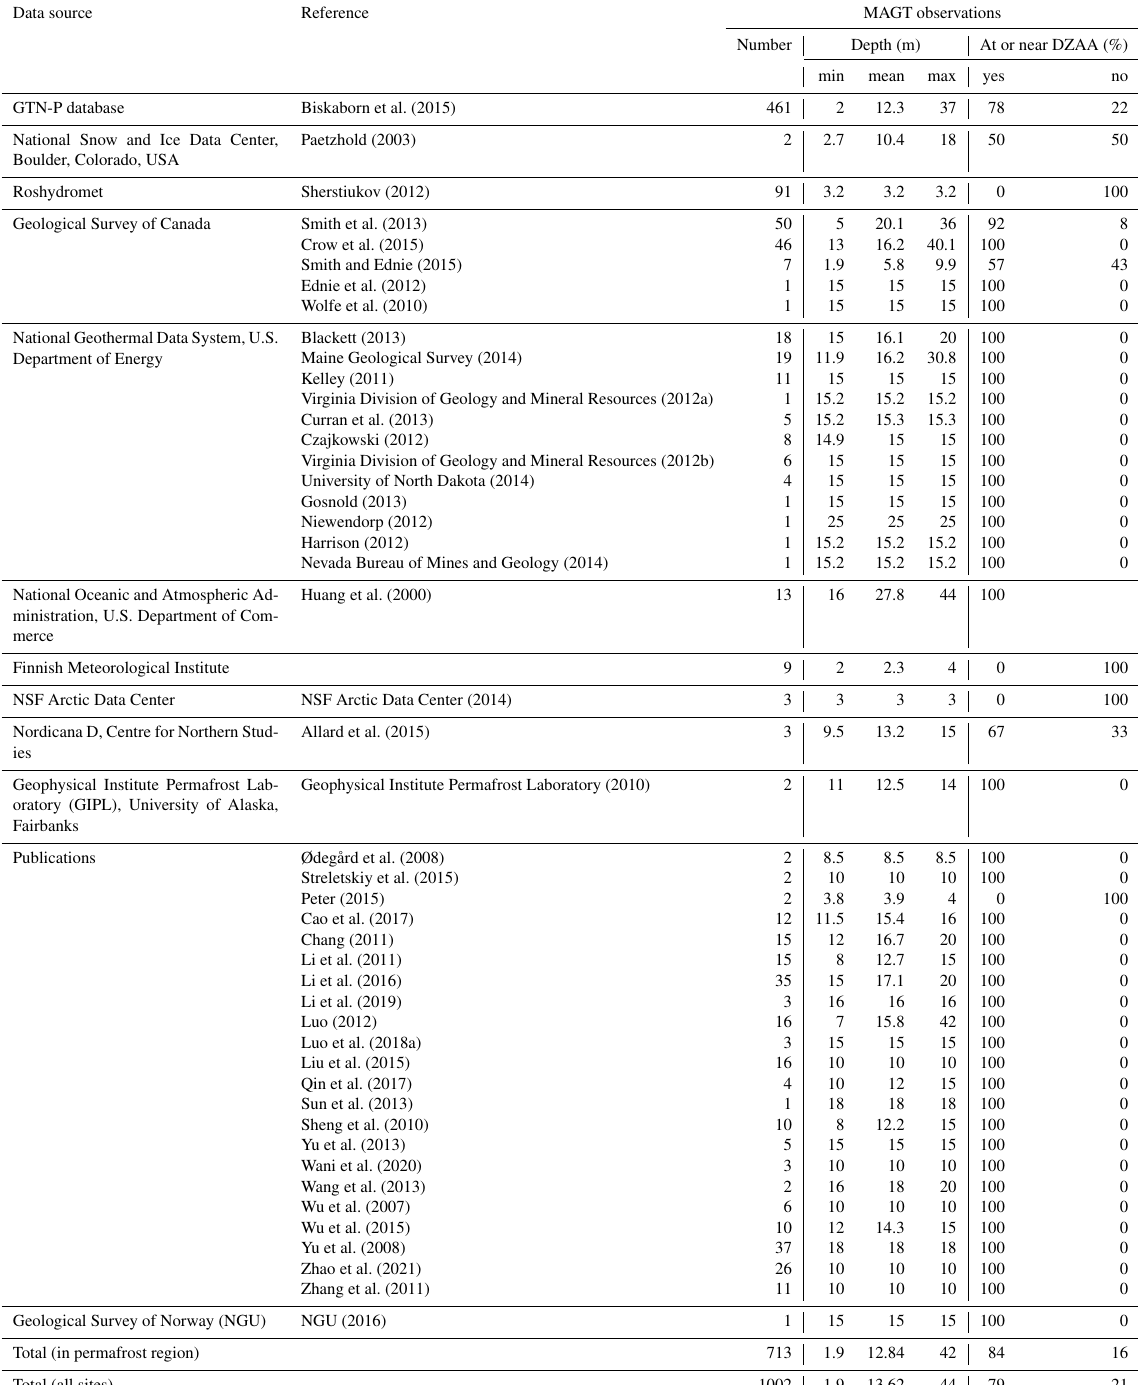
Table A1. Data sources used to compile mean annual ground temperature (MAGT) datasets for the period 2000–2016. The number of observations, minimum, mean, and maximum depths of MAGT, and proportions of MAGT measured at or near the depth of zero annual amplitude (DZAA) are provided for each